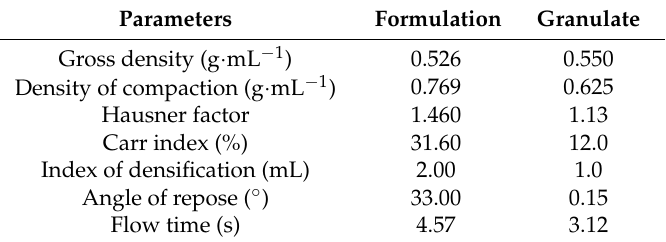
Table 3. Flow characterization data.